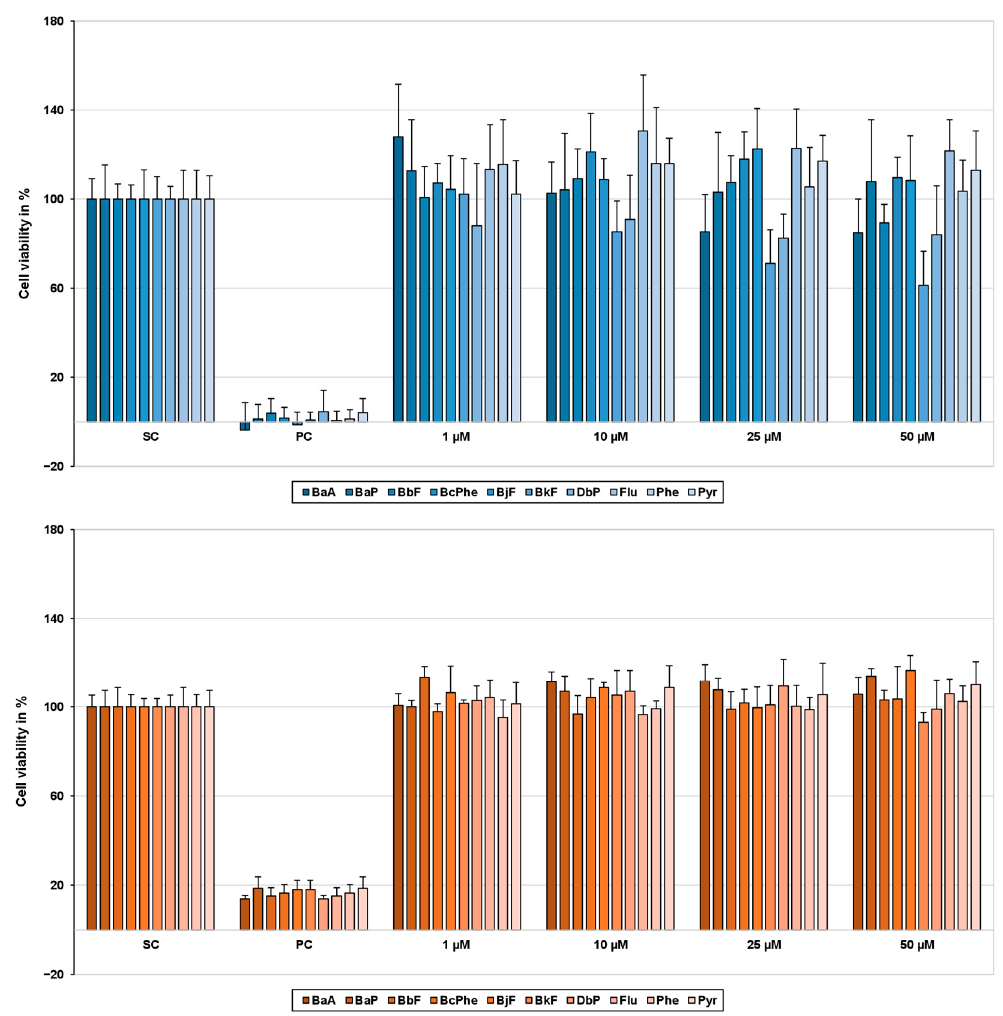
Figure 2. Cell viability of HepG2 (blue) and HepaRG cells (orange) 24 h and 48 h after polycyclic aromatic hydrocarbon (PAH) treatment, respectively. To determine cell viability, the 3-(4,5-dimethylthiazol-2-yl)-2,5-diphenyltetrazolium bromide (MTT) assay was performed. After treatment with the test compounds, 10 µ L MTT (5 mg/mL in PBS) was added to each well and incubated for 2 h (37 ◦ C, 5% CO 2 ). To dissolve the blue-colored formazan crystals, incubation medium was exchanged for 130 µ L/well pre-warmed desorption solution (0.7% sodium dodecyl sulphate (SDS) in propan-2-ol) and gently shaken for 15 min. Afterward, absorbance was measured at 590 nm on a Tecan Infinite M200 Pro spectrophotometer (Tecan group, Männedorf, Switzerland). Obtained data were normalized to the solvent control (SC); 0.01% Triton-X 100 served as a positive control (PC). Results are expressed as mean + SD, n = 3.